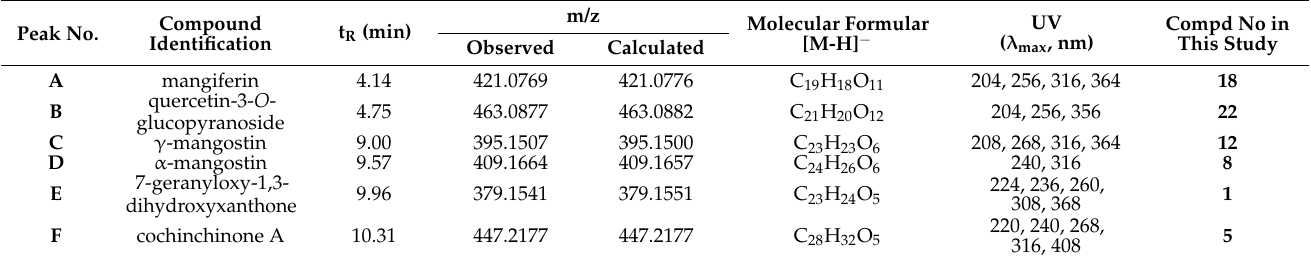
Table 2. Peak profiling by LC-MS/MS from leaves, roots and stems of C. formosum ssp. pruniflorum . Peak